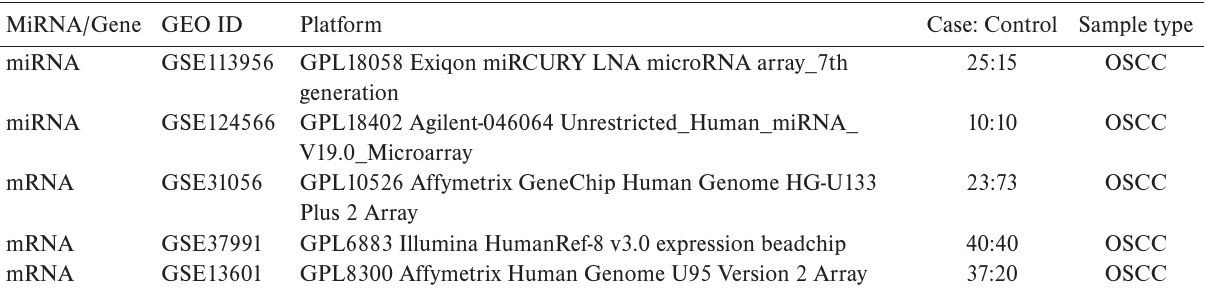
Table 1. The basic information of miRNA and mRNA expression microarrays in OSCC. MiRNA/Gene GEO ID Case: Control Sample type